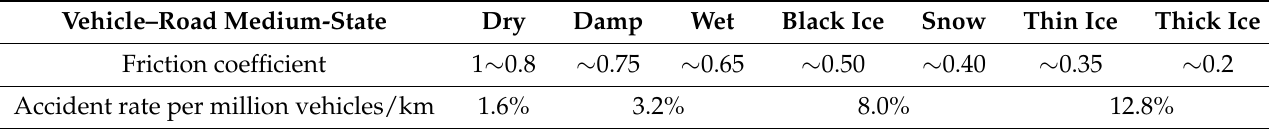
Figure 2. Tribosystem evaluated in this study. Table 1. Friction coefficient at different RSC [11,12].